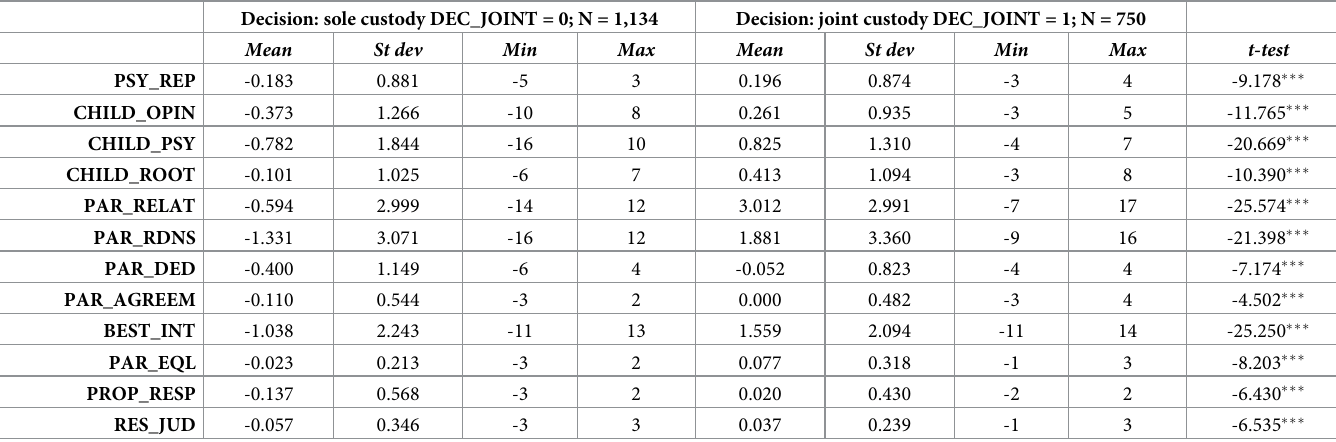
Table 3. Sample descriptives using t-test for equality of means.